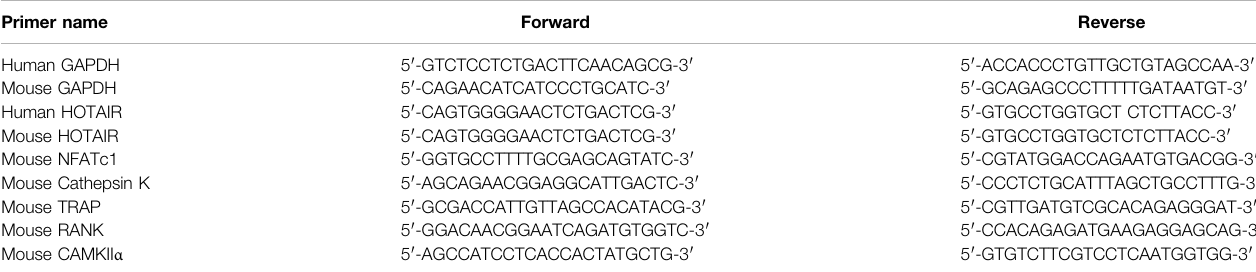
TABLE 2 | Primer sequences for all